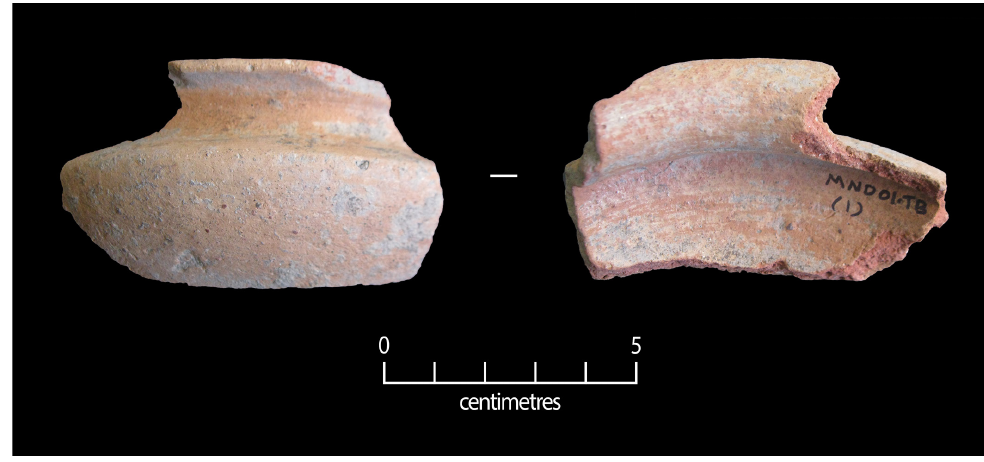
Figure 22: External surfaces of a Class 6 variant 2